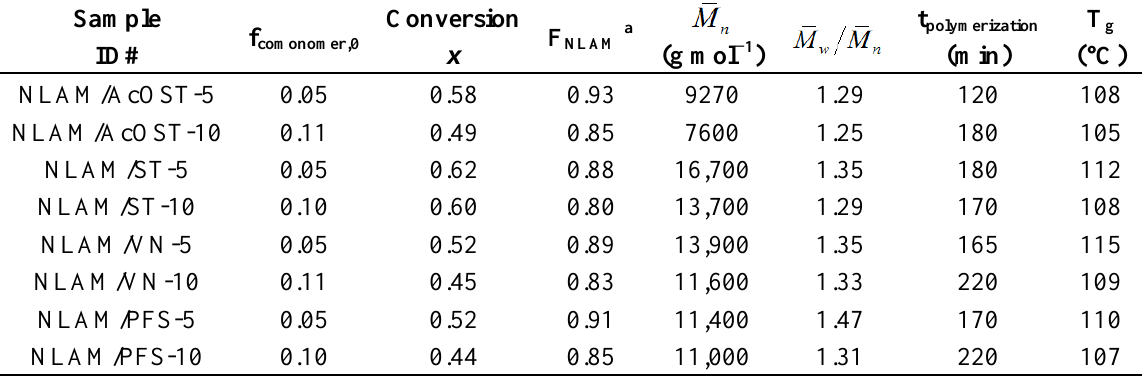
Table 3. Molecular characterization of NLAM/X (X = controlling co-monomer) random copolymers synthesized at 90 °C in 35 wt% 1,4 dioxane solution with BlocBuilder ® and additional SG1 free nitroxide.